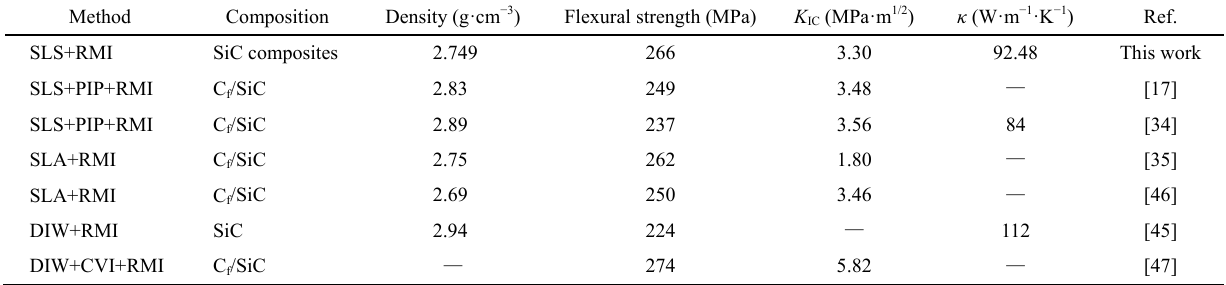
Table 5 Comparison of mechanical and thermal properties by different additive manufacturing techniques